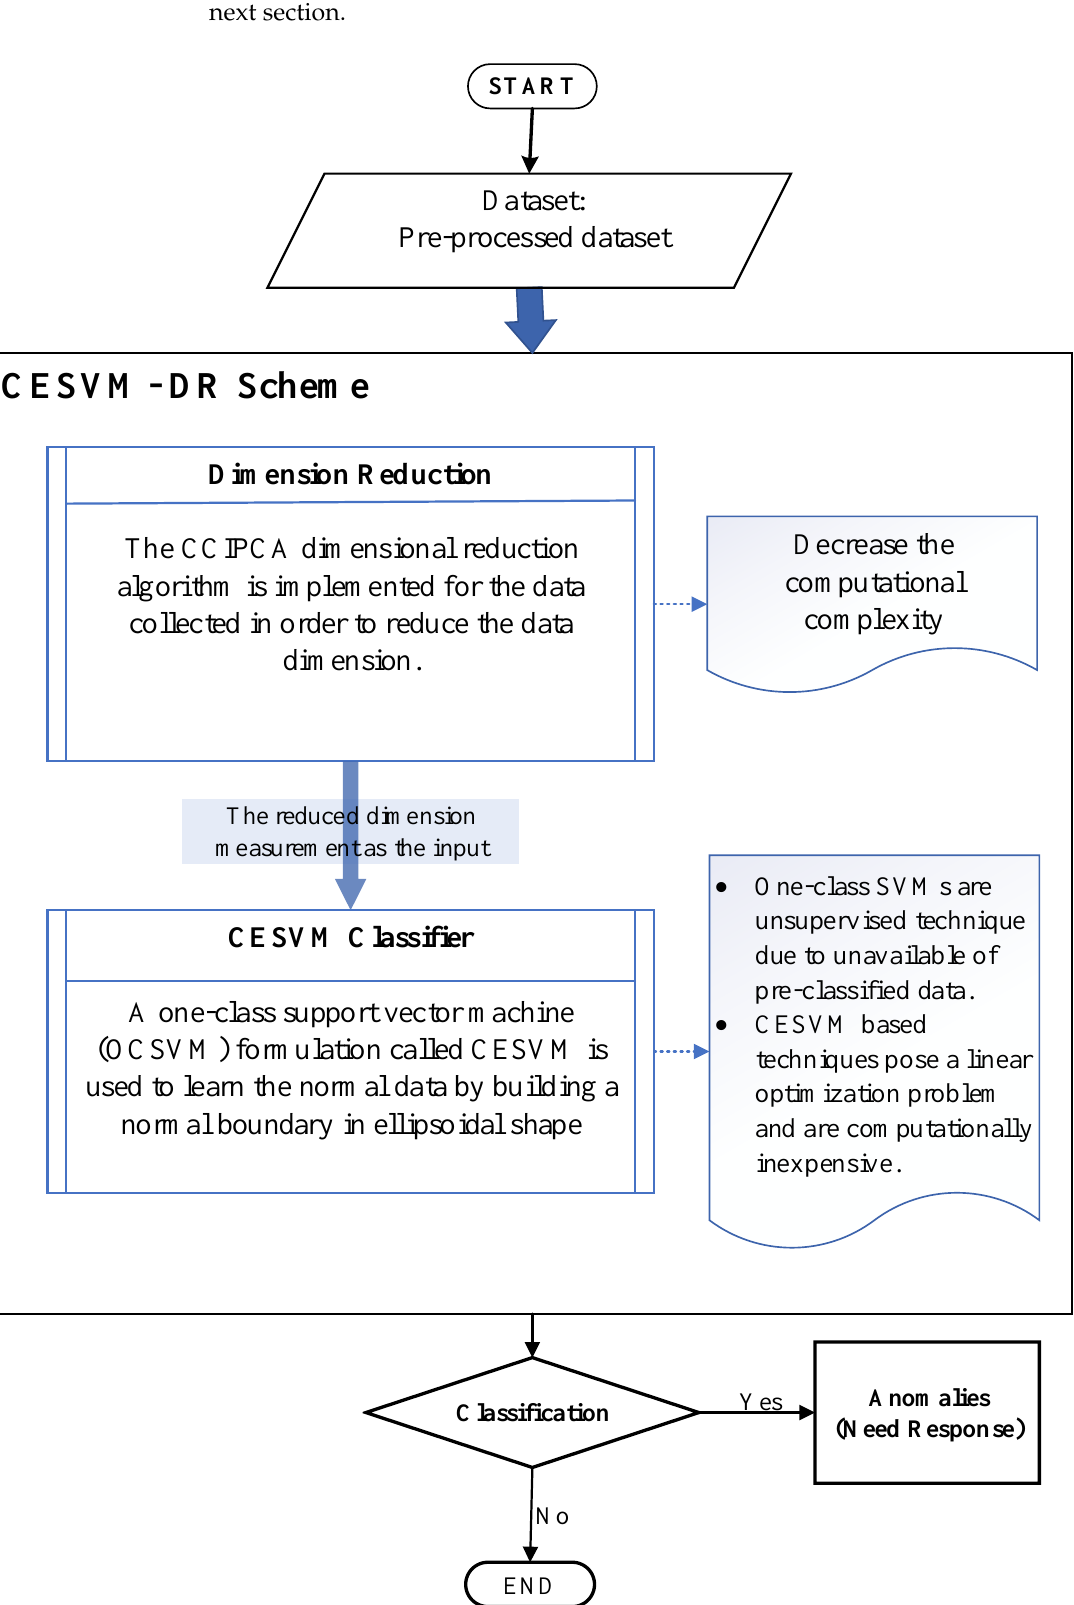
Figure 1. The Overview of Proposed CESVM-DR anomaly detection